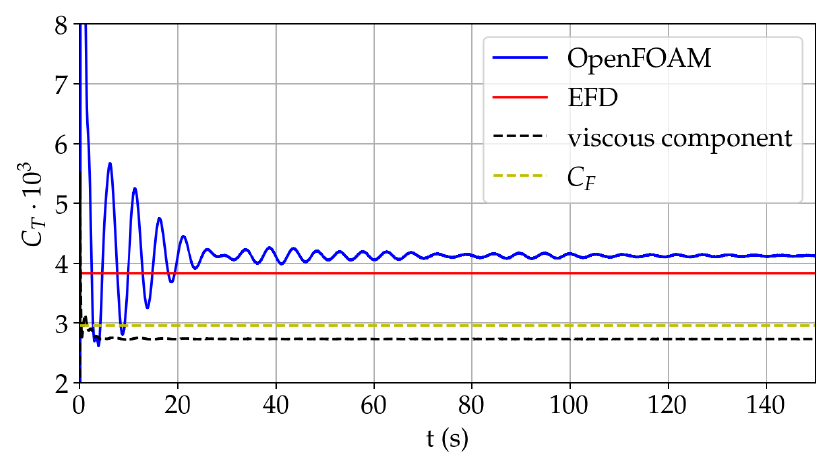
Figure 21. Time histories of horizontal forces on the KRISO containership in calm water and Re = 1047 × 10 7 .